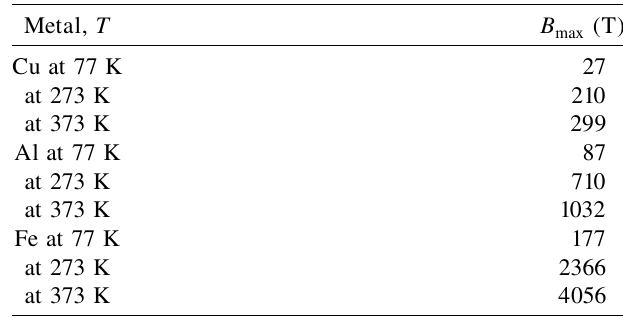
TABLE III. Limits on the magnetic field beyond which mag- netoresistance must be taken into account for three metals and temperatures, using the relaxation times of Table I.